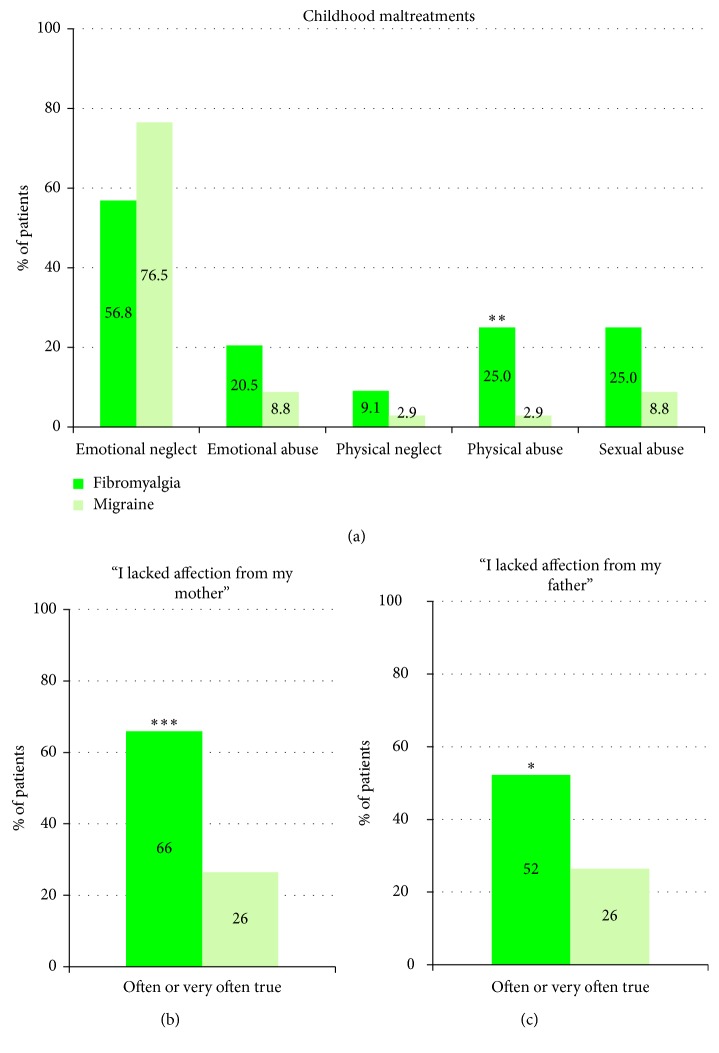
Childhood trauma evaluation. (a) Results of the Childhood Trauma Questionnaire (CTQ) assessing maltreatments of children from their familial environment: percentage of adult fibromyalgia and migraine patients who reported childhood abuses and neglects. (b, c) Percentage of patients who declared having often or very often suffered from maternal (b) or paternal (c) affective deprivation during childhood. Statistical significances between the two groups: ∗p < 0.05, ∗∗p < 0.01, and  ∗∗∗p < 0.001.